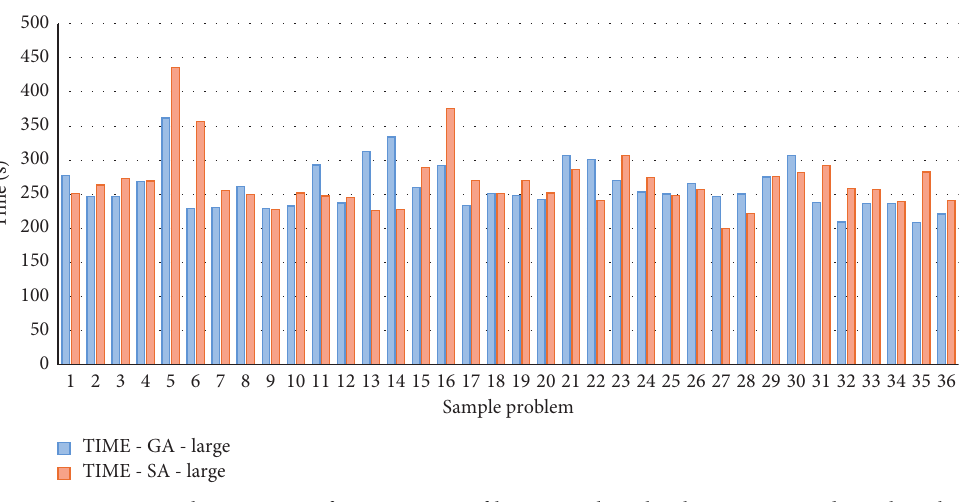
Figure 8: Comparison the outcomes of running time of large size algorithm between GA and SA